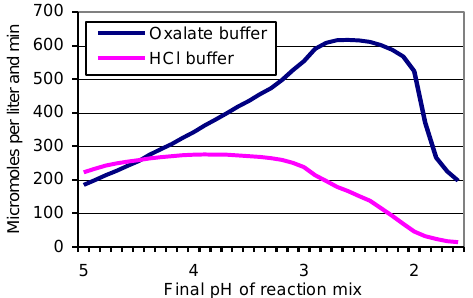
Figure 2. Oxidation of ABTS (µmol L −1 min −1 ) by culture filtrate of Km 10 in phosphate buffer pH 5, increasingly acidified with oxalate or HCl to result in final pH values of the reaction mixtures down to 1.6 ( n = 2).